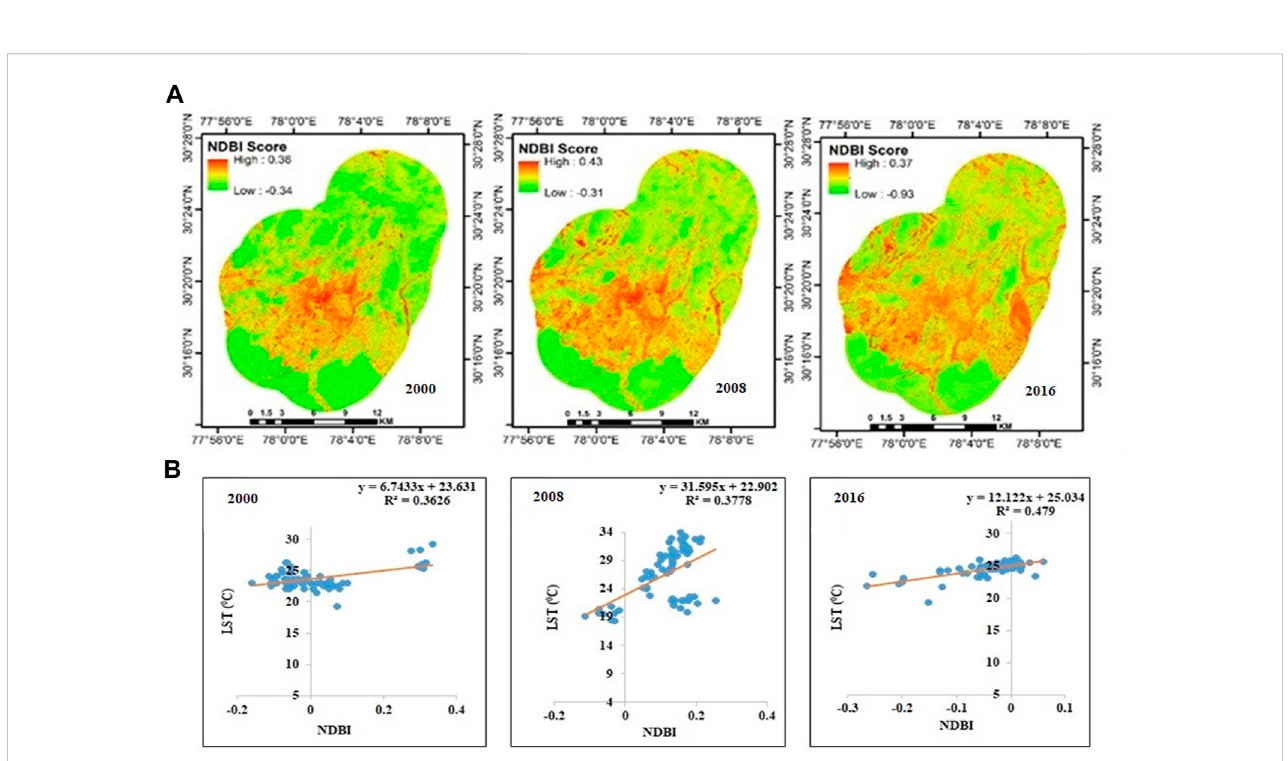
FIGURE 4 Change in NDBI (A) and degree of association of NDBI with LST (B) for Dehradun.